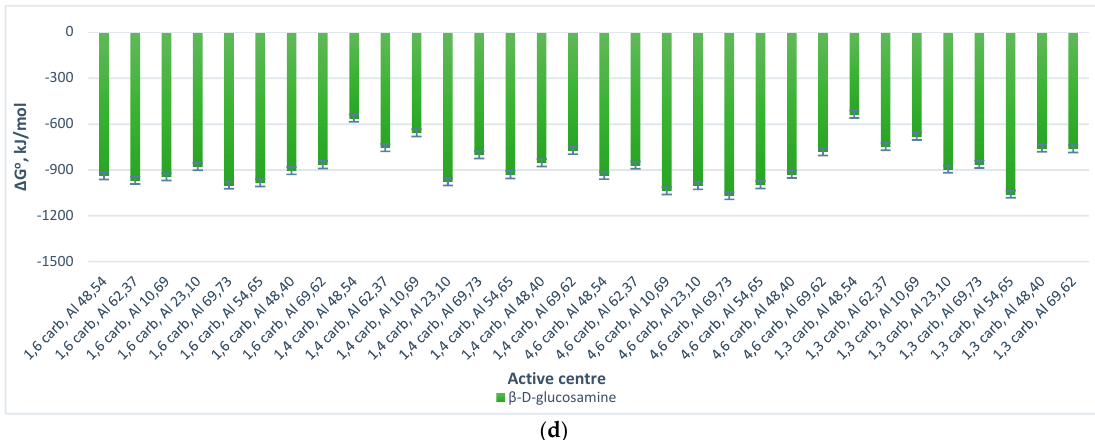
Figure 3. The development of the Gibbs energy change of formation of the Al 13 -monosacharide complex, depending on the active centers of the solvated Al 132+ complex and monosaccharide for the double-O-ligand coordination of the following monosaccharides: ( a ) β -D-glucopyranose, β -D-galactopyranose, α -D-glucopyranuronic acid, and β -D-mannopyranose; ( b ) β -L-rhamnopyranose and β -L-fucopyranose; ( c ) α -L-arabinofuranose; ( d ) β -D-glucosamine. (Notes: “carb” stands for carbohydrate; the first two numbers in the name of a complex are related to the pair of the carbon atoms with the adjacent oxygen atoms in the structure of the relevant monosaccharide, which participate in the coordination, and the second two numbers stand for the numbers of the aluminum atoms (active centers) of the Al 13 complex, which interact with the above-mentioned oxygen centers of the monosaccharide.).